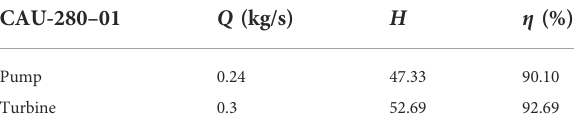
TABLE 6 BEP Point performance characteristic data.